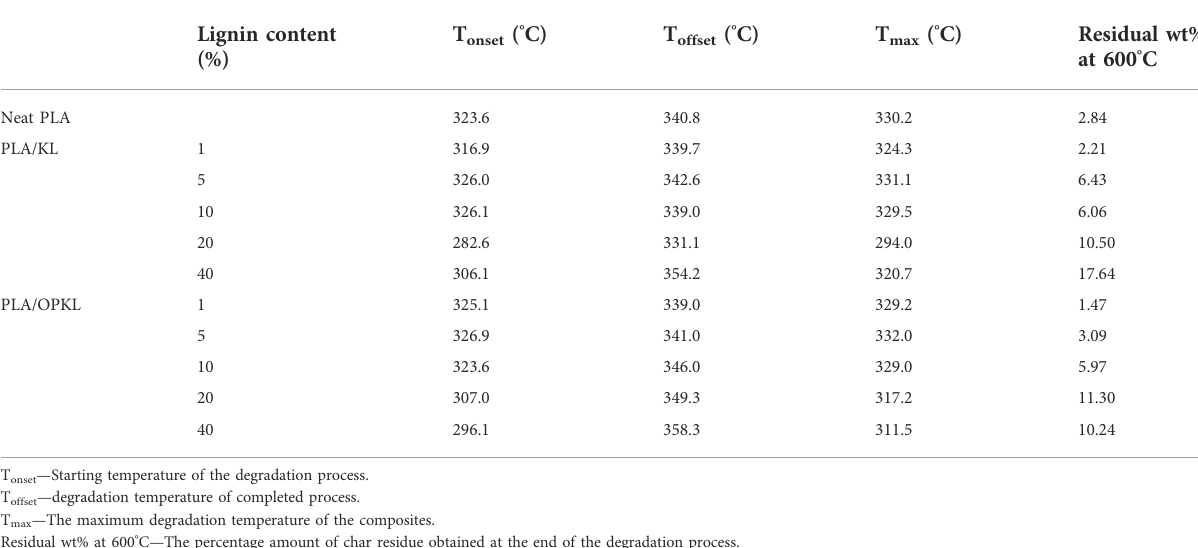
TABLE 1 Thermal properties of neat PLA, PLA/KL and PLA/OPKL composites.